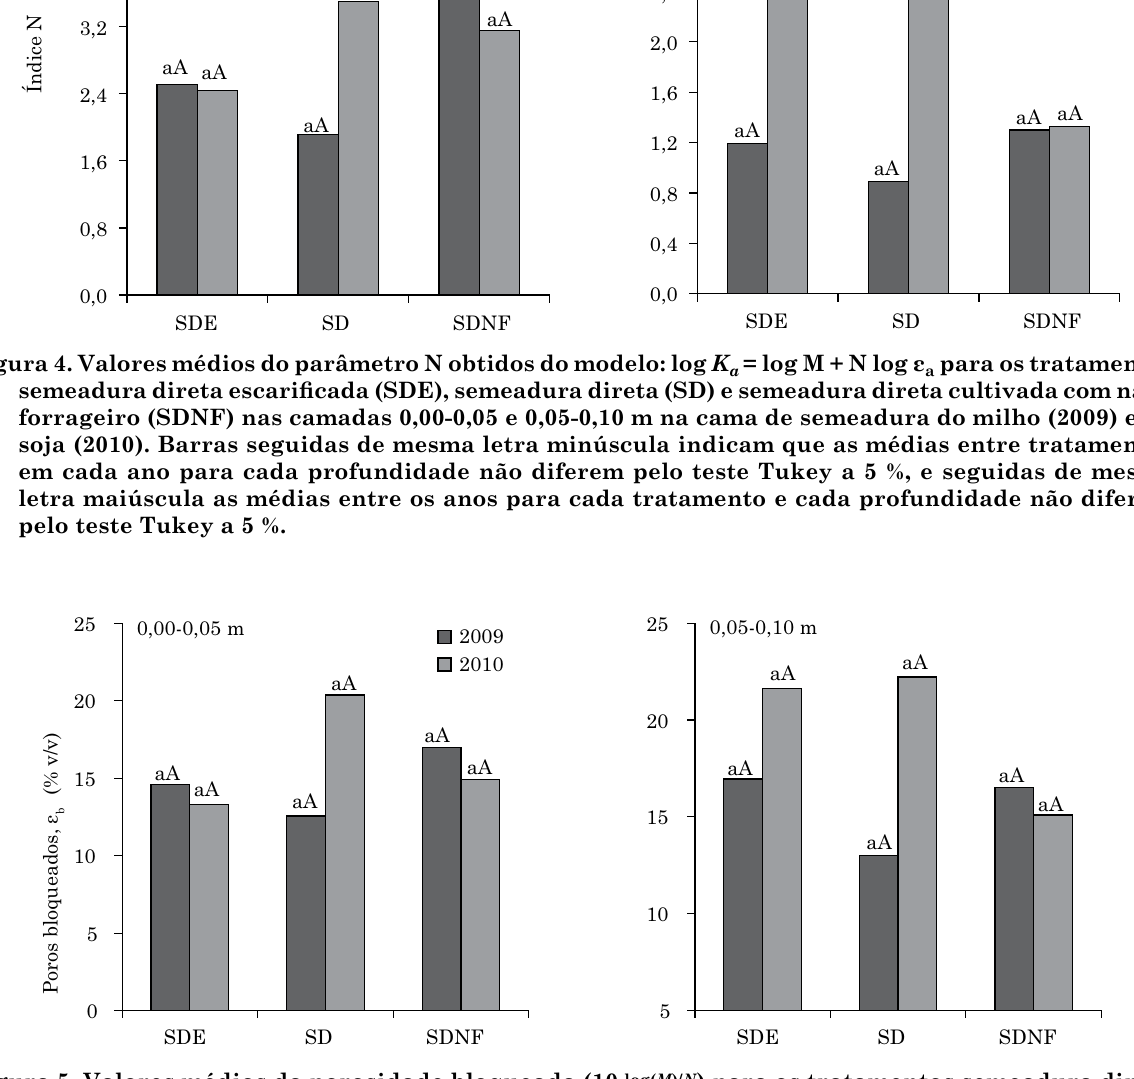
Figura 5. Valores médios da porosidade bloqueada (10 -log( M )/ N ) para os tratamentos semeadura direta escarificada (SDE), semeadura direta (SD) e semeadura direta cultivada com nabo forrageiro (SdNF) nas camadas 0,00-0,05 e 0,05-0,10 m na cama de semeadura do milho (2009) e da soja (2010). Barras seguidas de mesma letra minúscula indicam que as médias entre tratamentos em cada ano para cada profundidade não diferem pelo teste Tukey a 5 %, e seguidas de mesma letra maiúscula as médias entre os anos para cada tratamento e cada profundidade não diferem pelo teste Tukey a 5